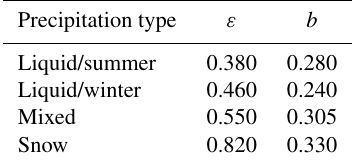
Figure 1. The Geodetic Observatory Wettzell, including the posi- tion of hydrological and gravimetric monitoring systems used in this study. The inserted figure shows the region surrounding the obser- vatory with a digital elevation model (DEM) with minimum (black) and maximum (white) elevation of 379 and 911m, respectively. Co- ordinates for the Universal Transverse Mercator (UTM), zone 33N, are in meters. Table 1. Parameters used at the Wettzell observatory to correct precipitation ( P) for under-catch by applying the equation P cor = P + bP ε . Liquid precipitation between March and November is treated as summer rain; liquid precipitation during the other months as winter